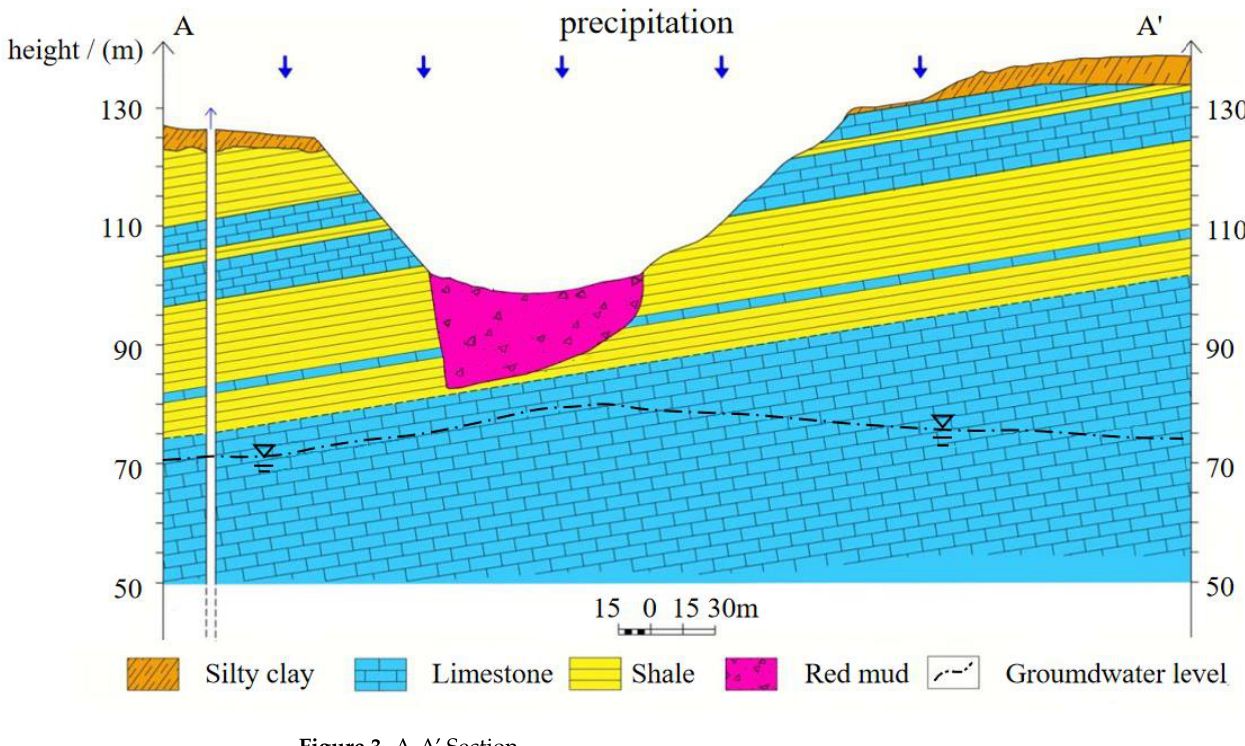
Figure 2. Hydrogeological map of the study area.